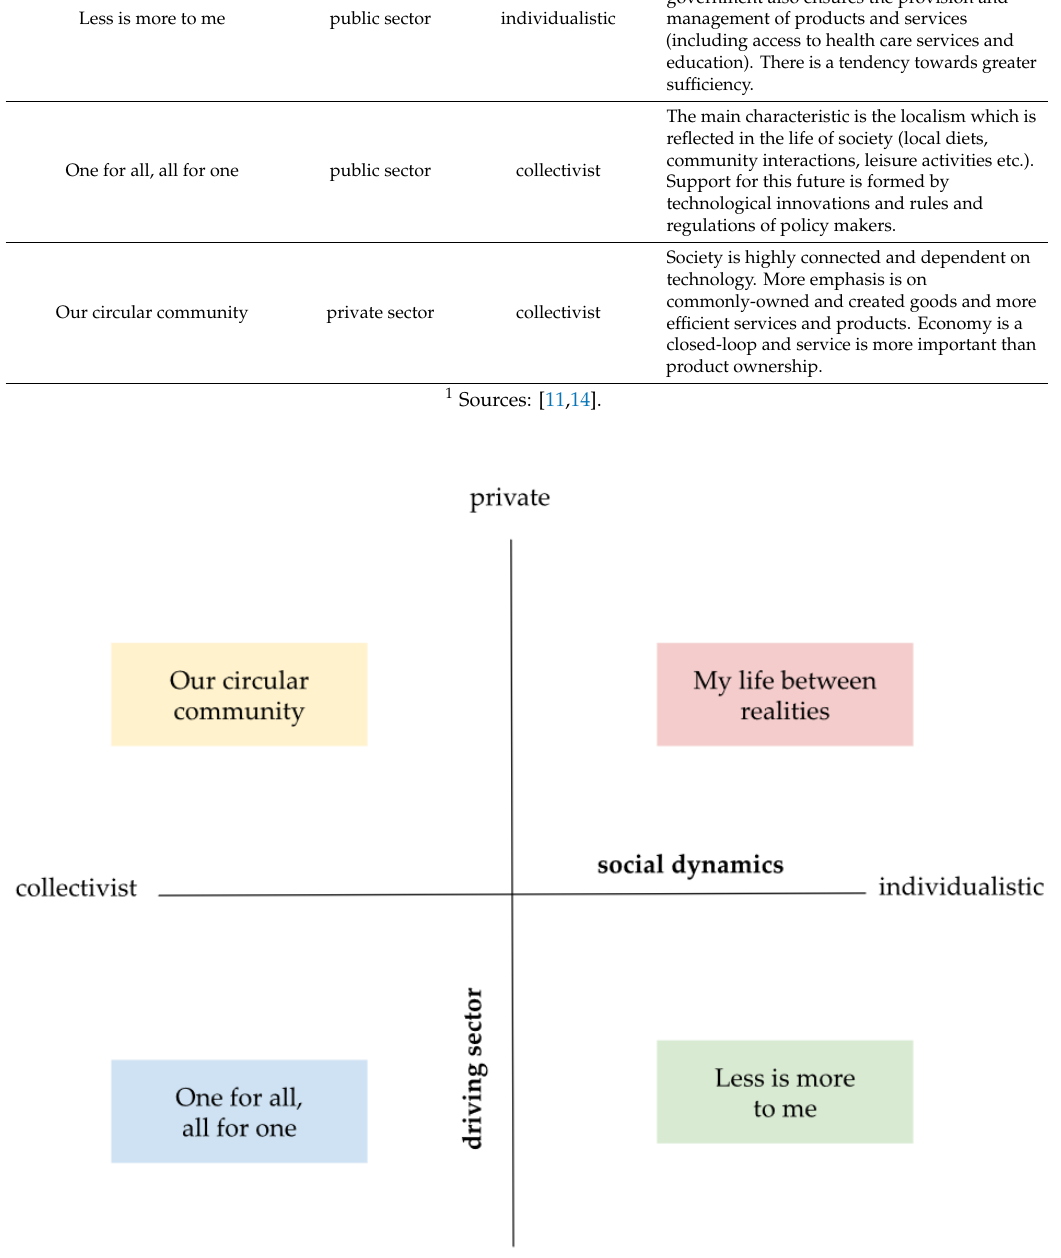
Table 1. Definition of the future scenarios 1 .